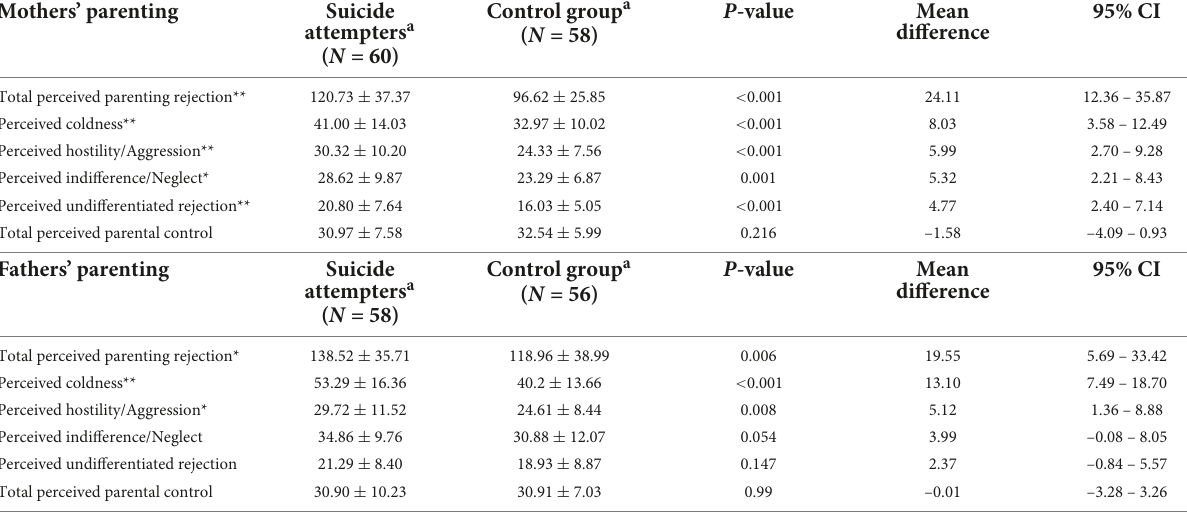
TABLE 5 Comparison between suicide attempters and control group’s perceptions of their parents’ parenting.